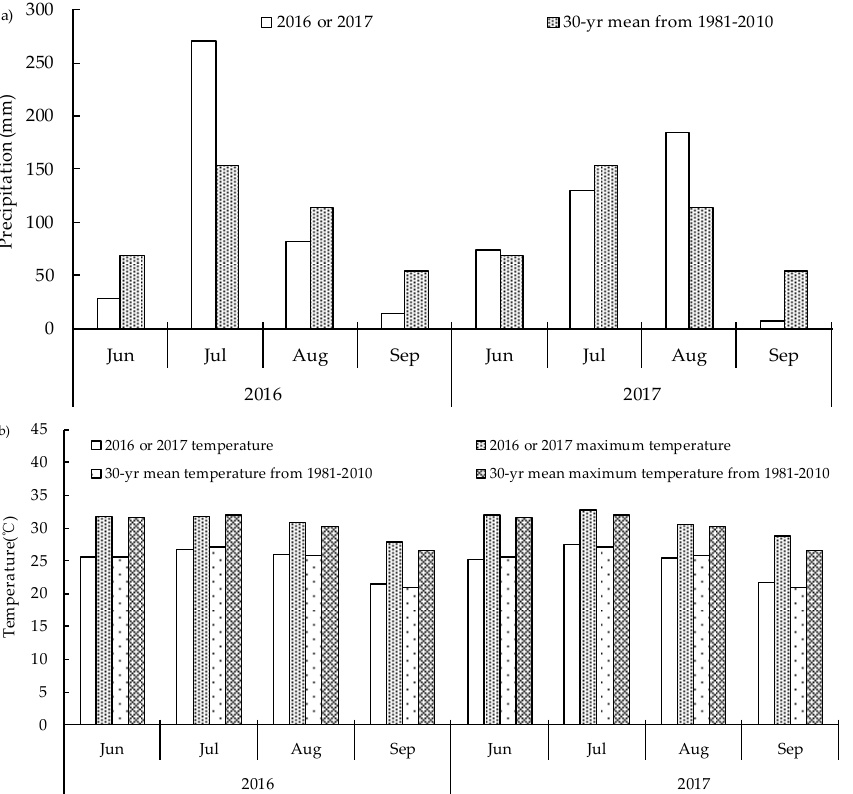
Figure 3. Mean monthly precipitations and temperature at the experiment site in 2016 and 2017 compared with the mean 30-year records (1981–2010) during the summer maize growing seasons, ( a ) Precipitation and ( b ) Temperature.